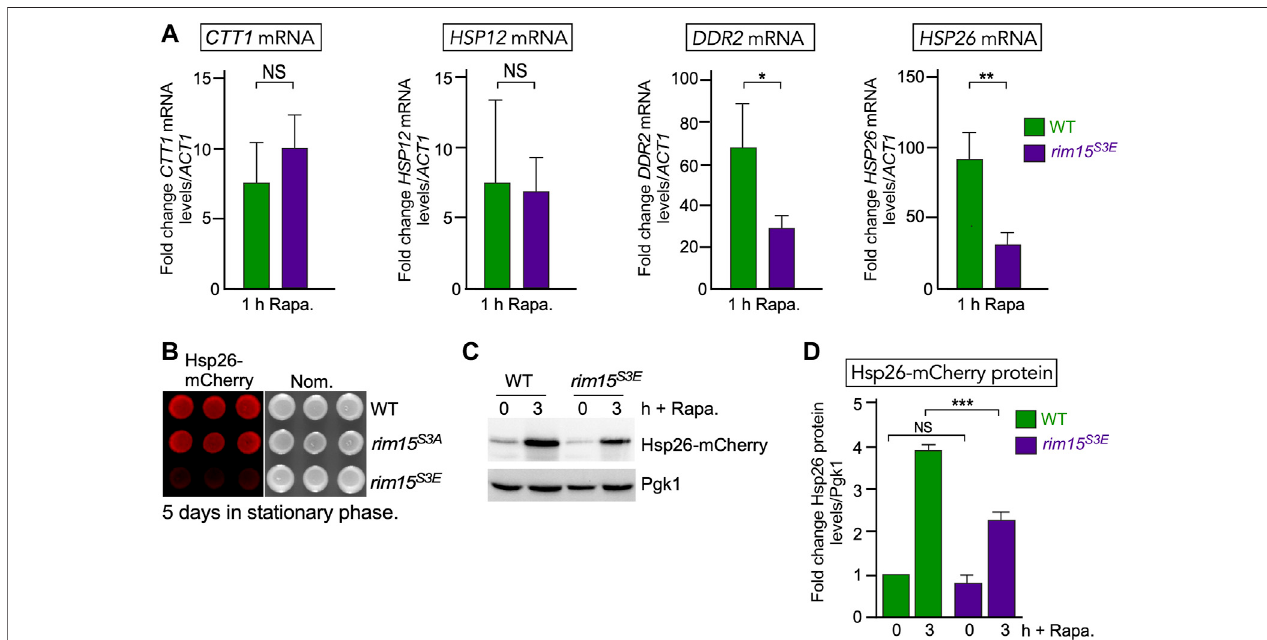
FIGURE 7 | The Rim15 phosphomimetic mutant ( rim15 S3E ) blocks induction of a subset of genes following nutritional stress. (A) RT-qPCR assays probing for mRNA of the genes shown in wild type (RSY10) and endogenous rim15 S3E (RSY2365). Transcript levels are given relative to the internal ACT1 mRNA control. The error bars indicate the standard deviation from the mean of two technical replicates from three independent cultures. NS p ≥ 0.05; * p ≤ 0.05; ** p ≤ 0.01. (B) Visualization of Hsp26-mCherryusing fl uorescenceimaginginthestrainsshownfollowing5 daysinstationaryphase.Threeindependentreplicatesareshown. (C) Representative Western blot of Hsp26-mCherry before and after 200 ng/ml rapamycin in wild type and endogenous rim15 S3E (RSY2365). Pgk1 levels were used as loading controls. (D) Quanti fi cation of Hsp26-mCherry levels analyzed in (C) . N = 3. NS p ≥ 0.05; *** p ≤ 0.005.